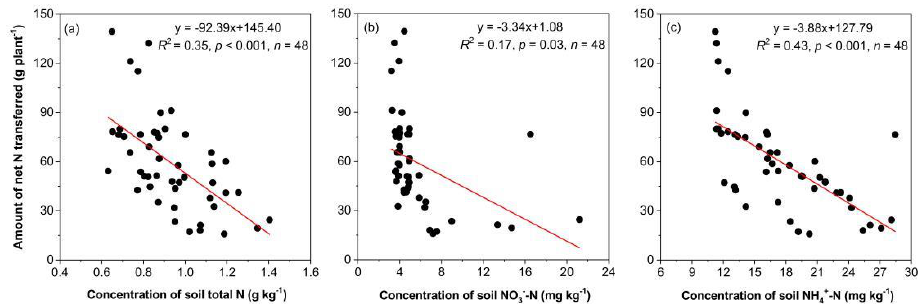
Figure 8. Correlations between the net amount of N transferred and the concentration of total soil N ( a ), nitrate nitrogen (NO 3 − -N) ( b ) and ammonium nitrogen (NH 4+ -N) ( c ). The y -axis represents the unidirectional transfer per pot, which was from D. odorifera to E. urophylla × grandis .